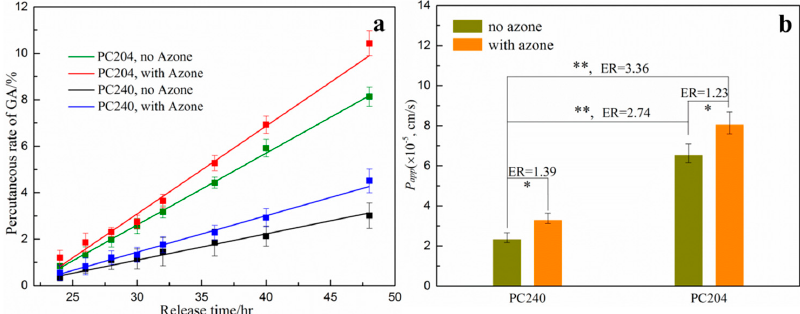
Figure 7. ( a ) In vitro cumulative diffusional release of GA penetrated through porcine ear skin from PC204 and PC240 hydrogel matrix with or without azone ( n = 3); and ( b ) the apparent permeability coefficient ( P app ) and enhancement ratio (ER) (* p < 0.05; ** p < 0.01; HPLC mobile phase: acetonitrile and double distilled water/phosphoric acid (99.0/1.0, v / v ), flow rate: 1.0 mL/min; the data for PC204 without azone extracted from [24]).